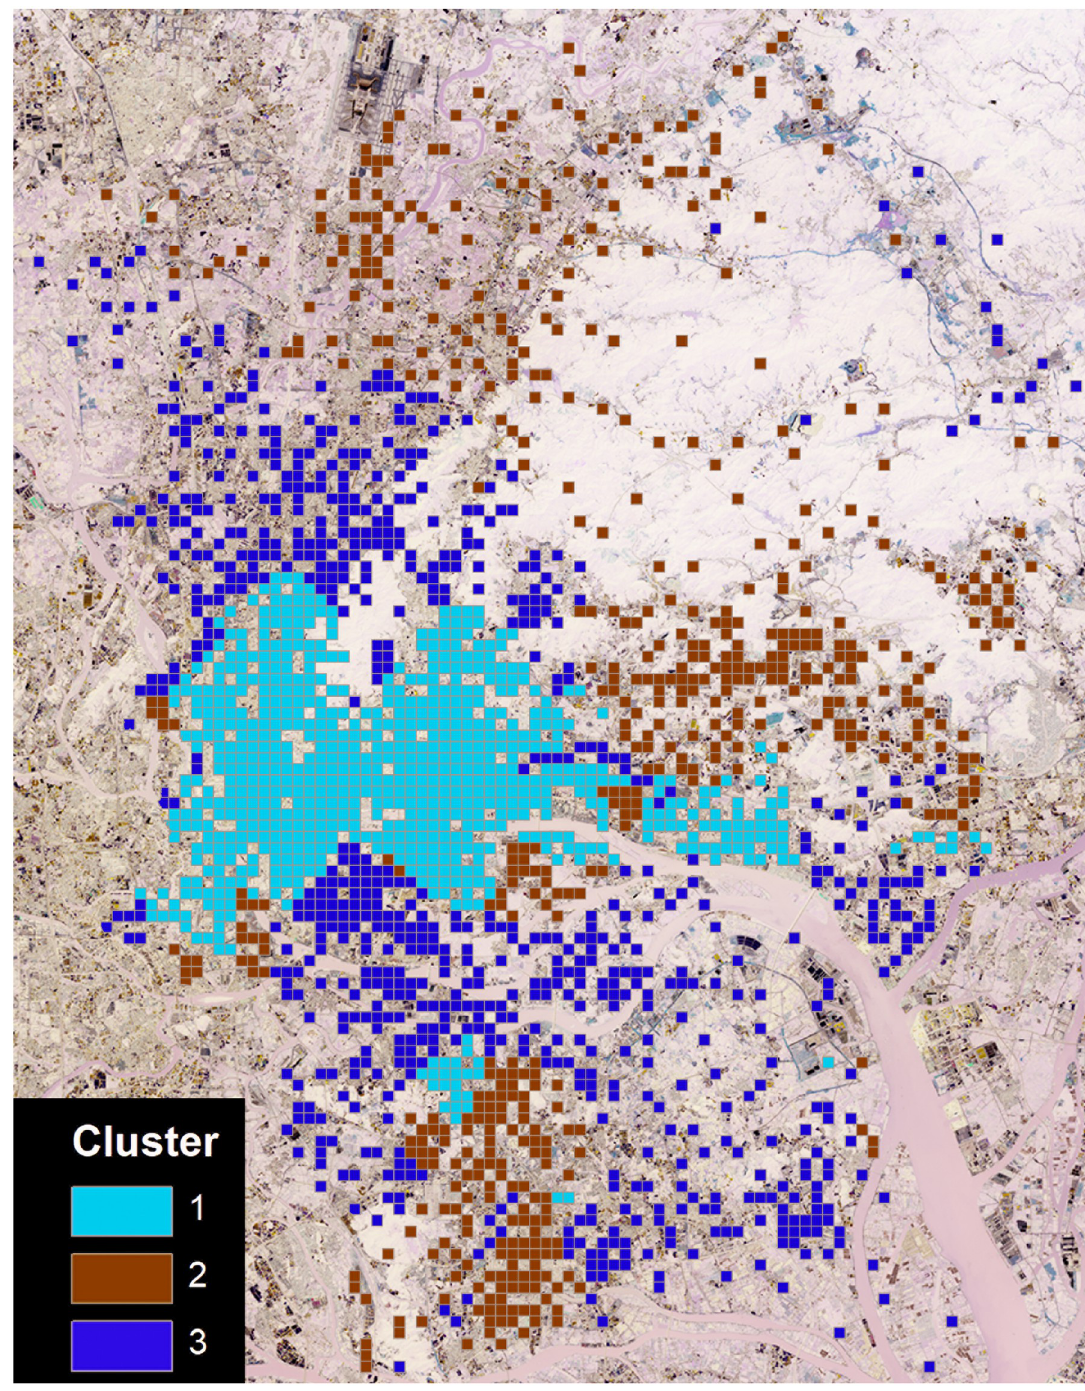
Fig 6. The spatial distribution of